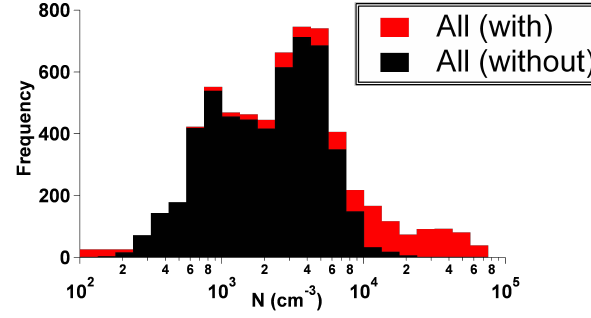
Fig. 5. Total aerosol/condensation nuclei concentrations ( d > 3nm) for all data including nucleation events (red) and all data exclud- ing nucleation events (black). The particle concentration data is averaged over